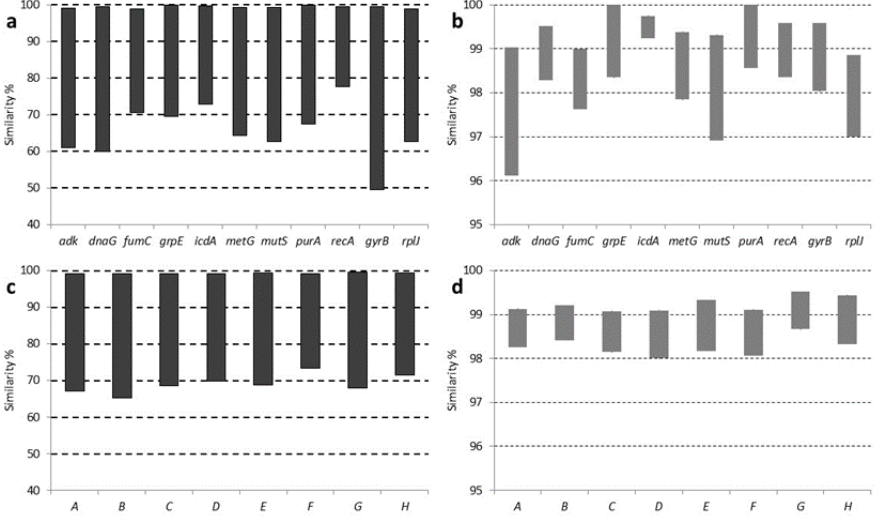
Figure 3. Taxonomic resolution based on the number of base di ff erences per site ( p -distance) between sequences from the Liberibacter ( a , c ) and CLso ( b , d ) phylogroups using individual genes ( a , b ) or multilocus sequence analysis (MLSA) approaches ( c , d ) by di ff erent concatenated gene combinations: adk-mutS-icdA (A), adk-dnaG-icdA (B), adk-dnaG-recA (C) , adk-mutS-recA (D,), adk-icdA (E), adk-recA (F), mutS-icdA (G), mutS-recA (H). The evolutionary history was inferred using the Maximum Likelihood method and the Tamura-Nei model [28]. Bootstrap values (1000 replications). Analysis was conducted in MEGA X